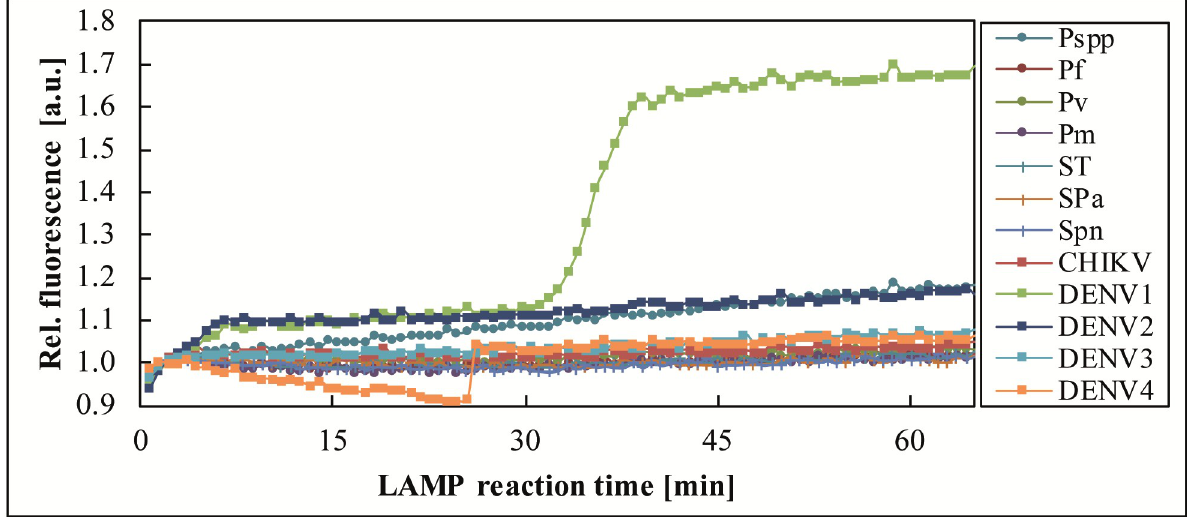
Fig 5. Detection of DENV and determination of initially unknown serotype. Sample 267197 is shown here; sample 267175 showed similar